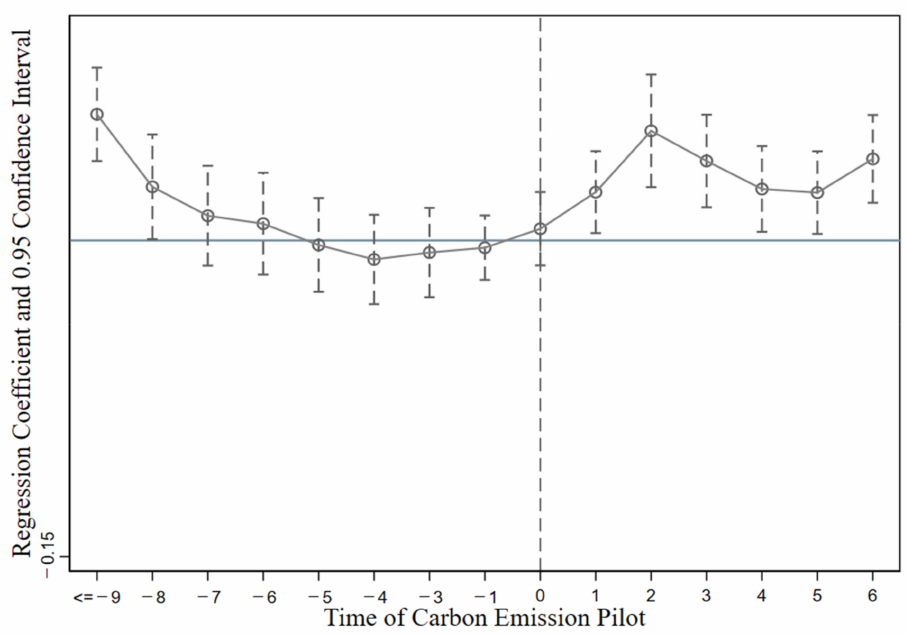
Figure 2. The test of parallel trend hypothesis and the dynamic trend of the pilot CET policy and companies’ market